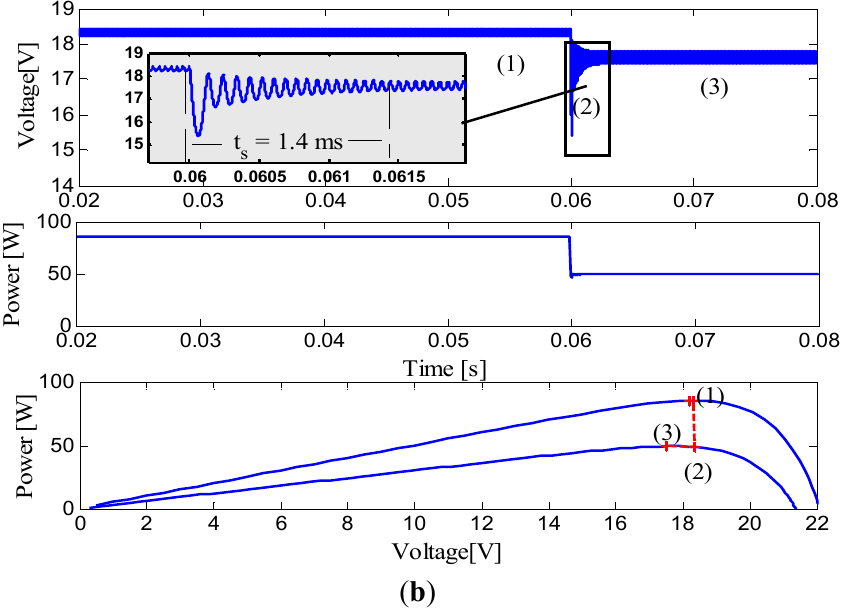
Figure 13. System Response to irradiance perturbations. ( a ) Transient from 600 W/m 2 to 1000 W/m 2 ; ( b ) Transient from 1000 W/m 2 to 600 W/m 2 .